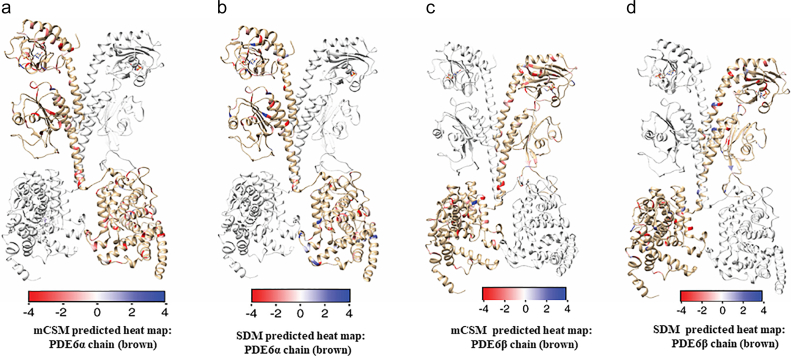
Heat maps based on mCSM and SDM predicted change in ΔΔG values of PDE6α and β chain. a) Shows mCSM while b) represents SDM predicted changes in protein stability of PDE6α chain upon COSMIC mutations. Similarly, c) shows mCSM while d) represents SDM predicted changes in protein stability of PDE6 β chain upon COSMIC mutations. Effect of mCSM and SDM predicted ΔΔG values for mutations occurring in PDE6αβ is depicted through a colored gradient scale, starting from blue indicating the average stabilizing effect (>0 kcal/mol) to highly destabilizing (<−2.00 kcal/mol) shown in red.